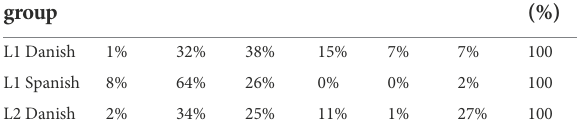
TABLE 3 Relative frequency of type of construction per participant